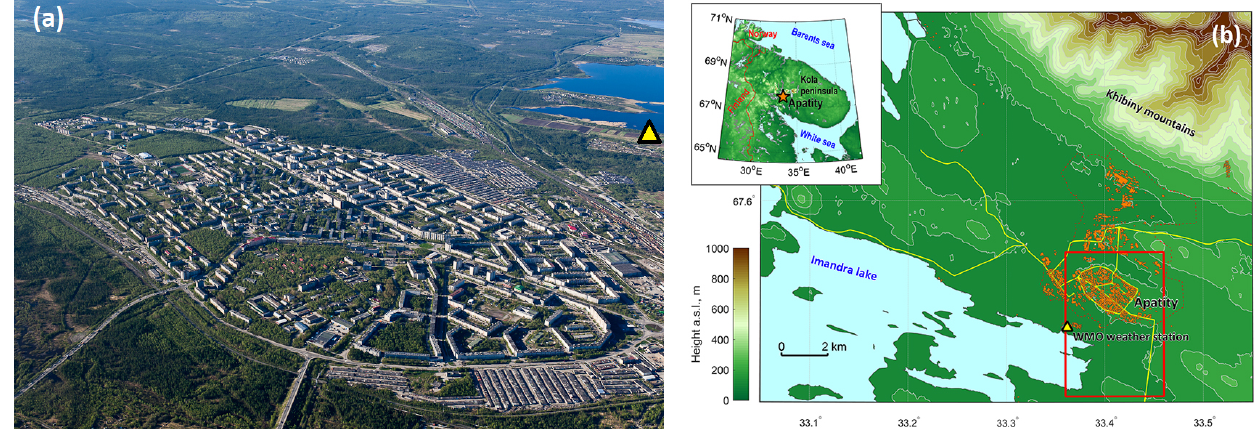
Figure 1. (a) An aerial view of Apatity in summer taken from the northern side of the city (photo credit: Boris Vakhmistov); (b) a relief map of Apatity. Colors show the elevation above sea level. Buildings are indicated in orange, major roads by yellow lines and the red dotted line shows the city administrative border. The red rectangle corresponds to the area shown in the aerial view (a) . The yellow triangles in (a) and (b) mark the location of the WMO weather station